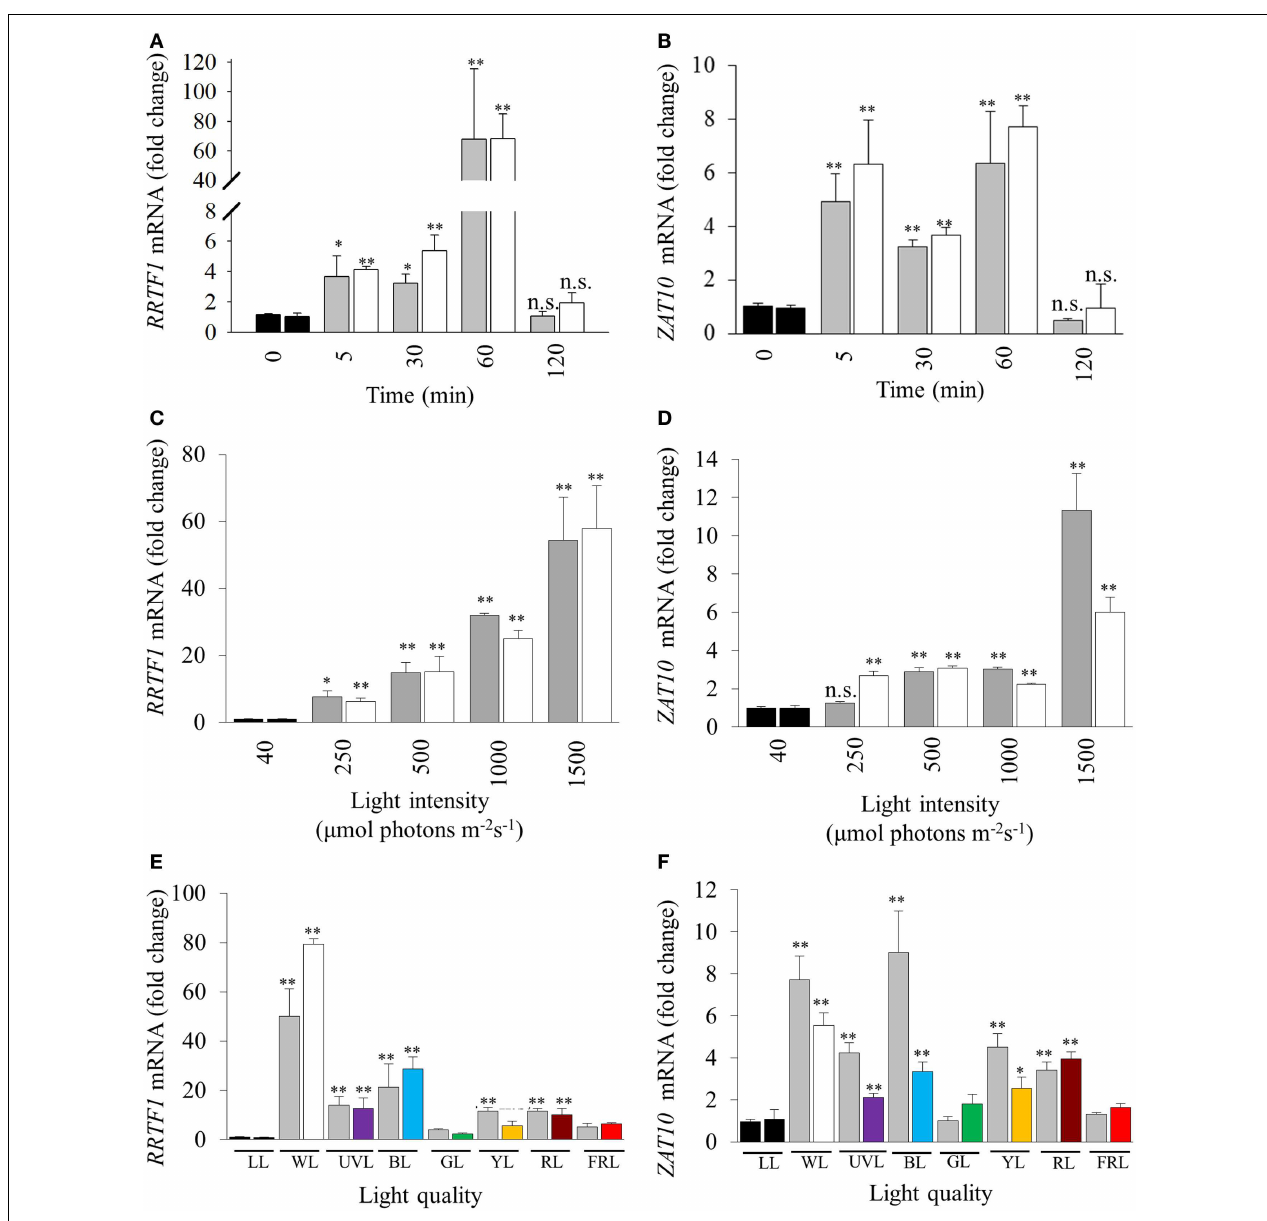
LL control plants (black, LL), distal (grey), white HL (WL), ultra violet light (UVL), blue (BL), green (GL), yellow (YL), red (RL), and far-red (FRL). For each sample n = 6, * p < 0.005, ** p < 0.001, n.s., not significant, error bars indicate standard error. LSD post hoc tests from one-way ANOVAs show that for both RRTF1 and ZAT10 plants under white and blue light LED treatments caused the significant SAA gene induction ( P < 0.05). For spectral details, Section “Materials and Methods” and Figure 1